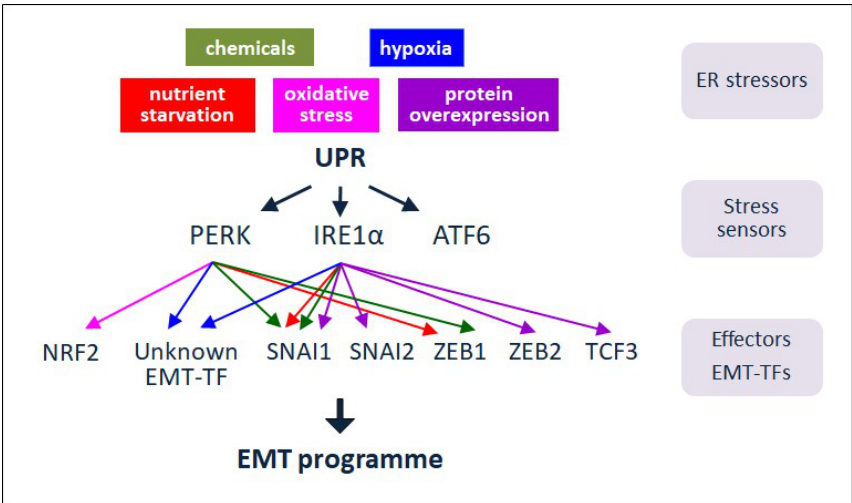
Figure 3. UPR signalling and EMT in cancer. In response to diverse ER stressors, UPR signalling is activated to relieve the stress and favour survival. In some tumours, the ER stress sensors and signalling players PERK and IRE1 are proposed to modulate EMT by impinging on particular EMT-TFs. Through the implementation of EMT, UPR can contribute to the progression and recurrence of tumours upon treatment. Thus, ER stress and UPR components can be exploited as plausible targets for anti-cancer therapy.